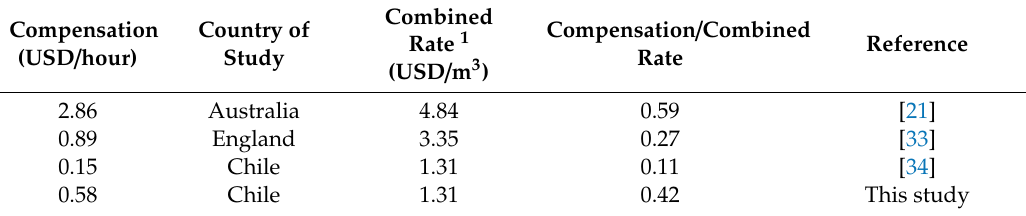
Table 7. References for compensation and combined rate